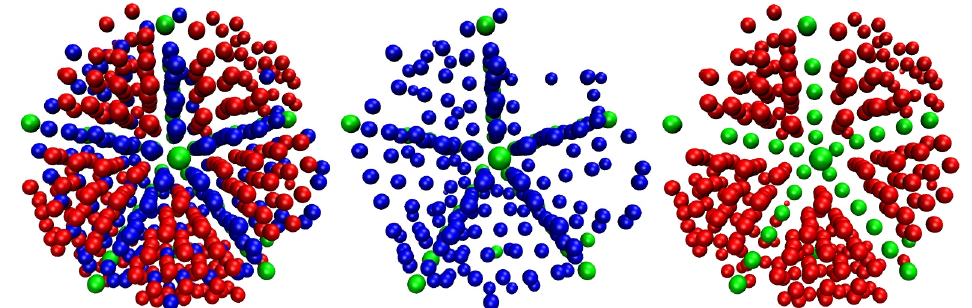
Figure 5. Typical cyclic twin structure ( left panel ) at frame 1622, early in Region II. View is along the twin axis [110] (perpendicular to the page). The twin axis is occupied by sites with fivefold symmetry; sectors are of mixed HCP ( middle panel ) and FCC ( right panel ) characters. Only a spherical portion of the simulation cell around the fivefold axis is depicted. Radius of spheres is reduced for clarity. Image created with the VMD visualization software